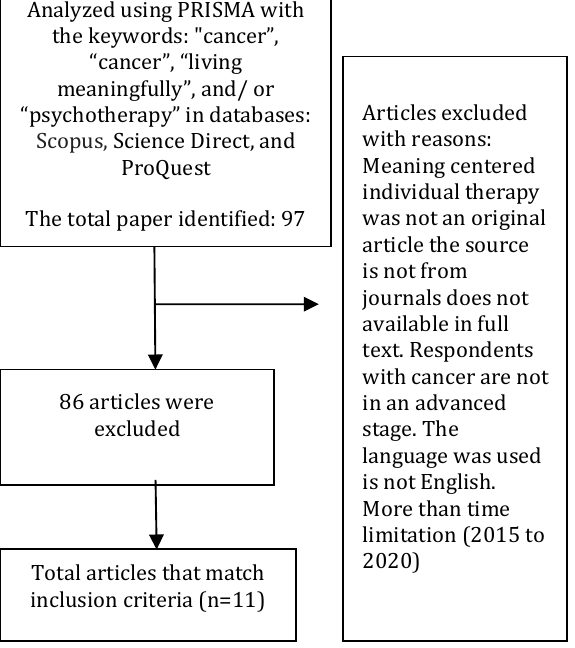
Figure.1. Flowchart of the research on Managing CALM for advanced